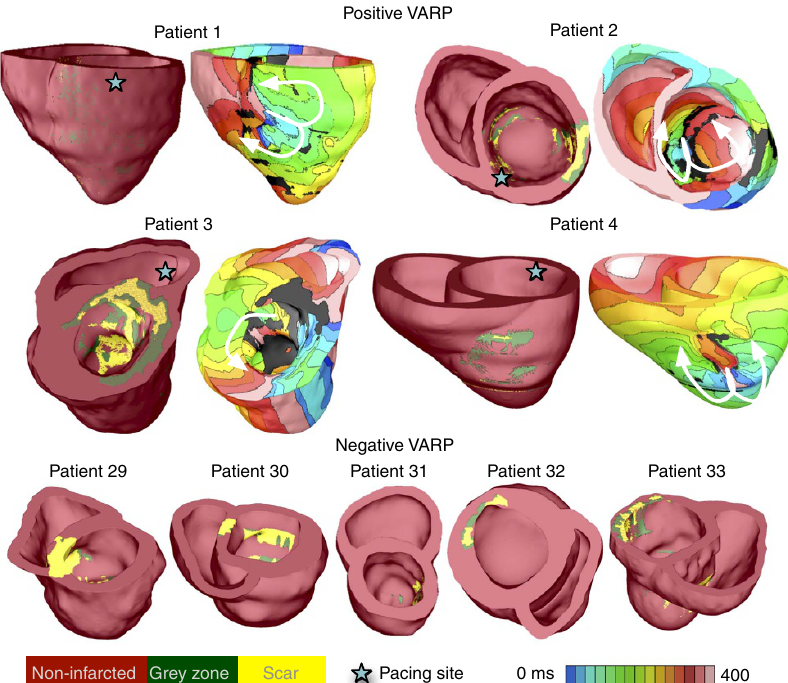
Figure 2 | Illustrative examples of VARP results for 9 of the 41 personalized heart models. Shown is the induced arrhythmia in four hearts (top), for which geometrical models are presented together with electrical activation isochronal maps, obtained following pacing from the site indicated by the star. White arrows represent the direction of propagation of the re-entrant arrhythmias. All induced arrhythmias were monomorphic ventricular tachycardias. The geometrical models of the five hearts, in which no arrhythmia was induced from any pacing site, are shown at the bottom.